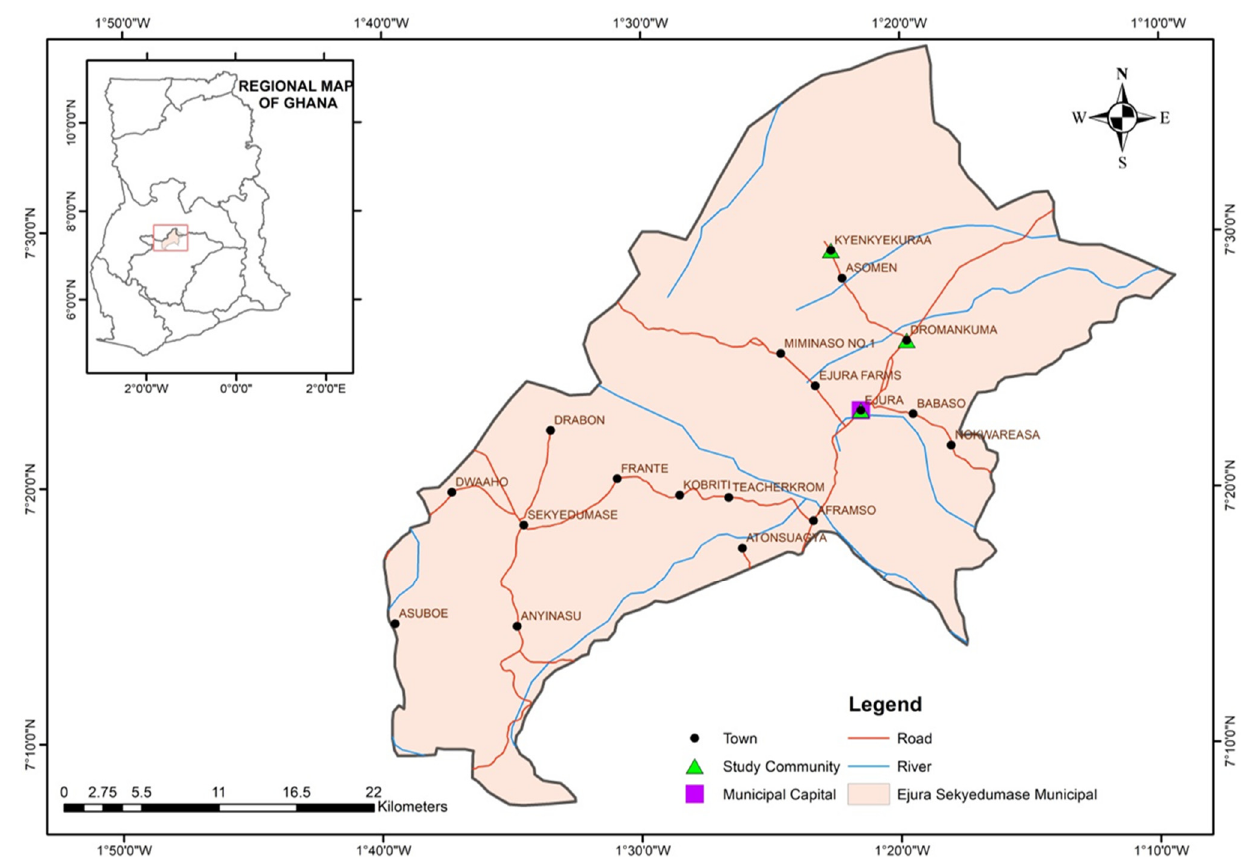
Figure 1. Ghana showing study communities.